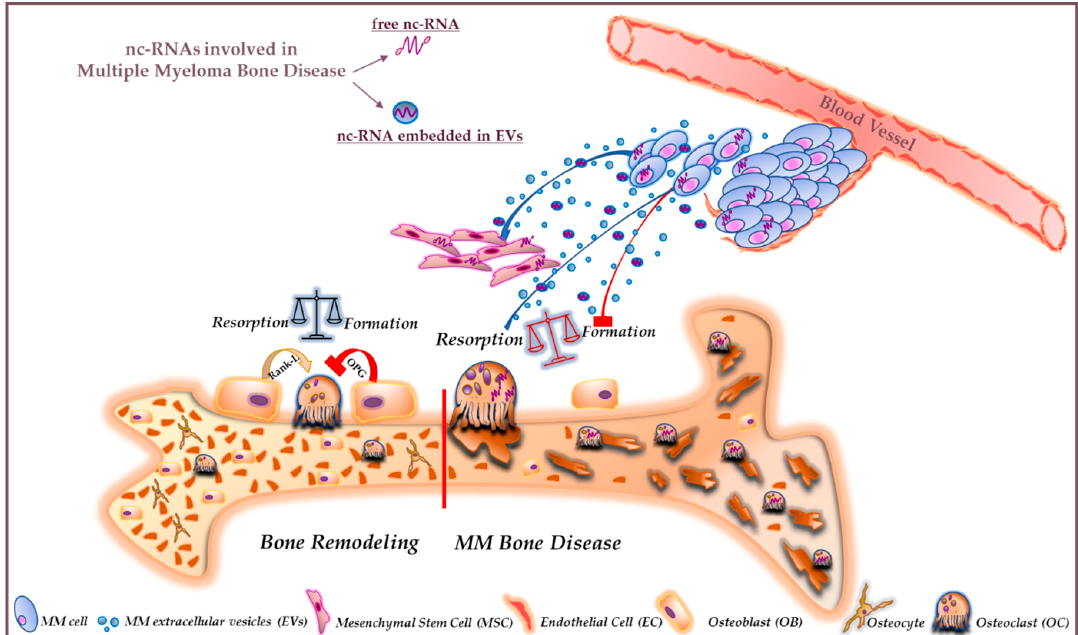
Figure 2. Cartoon showing the effect of dysregulated non-coding RNAs (ncRNAs) (miRNAs and long (>200 nucleotides) non-coding RNAs (lncRNAs)) on multiple myeloma bone disease (MMBD). ncRNAs modulate bone remodeling both in physiologic conditions (on the left side of the red line across the bone) or in MM (on the right side of the red line across the bone). Under physiologic conditions, osteoclasts (OCs) and osteoblasts (OBs) work together to balance bone resorption and